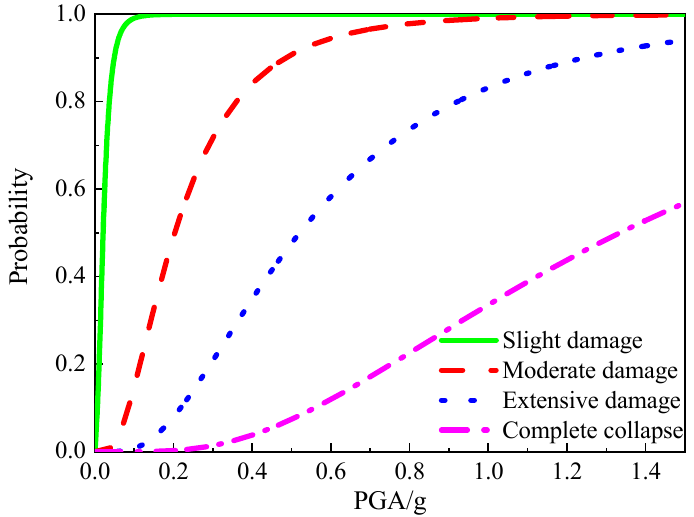
Figure 10. Exceeding probability curves.